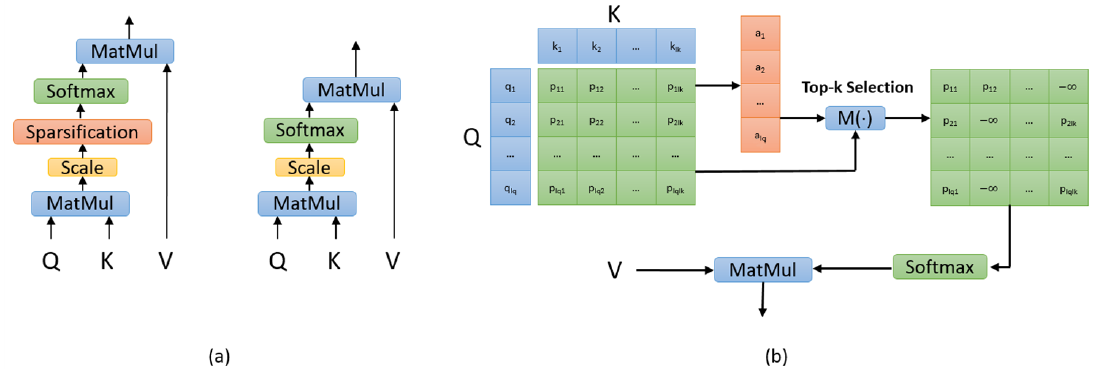
Figure 2. ( a ) The difference between sparse scaled dot-product attention (left) and ordinary dot-product attention (right). ( b ) The core calculation steps of sparse scaled dot-product attention. Through explicit selection based on top-k selection and softmax function, only the most contributive elements are assigned with